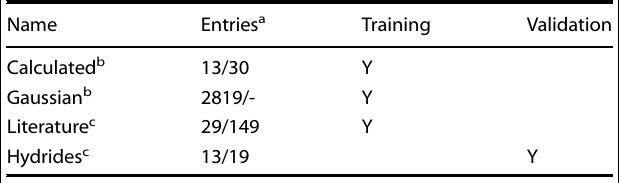
Table 1. Summary of the datasets used for training and validation of the machine learning